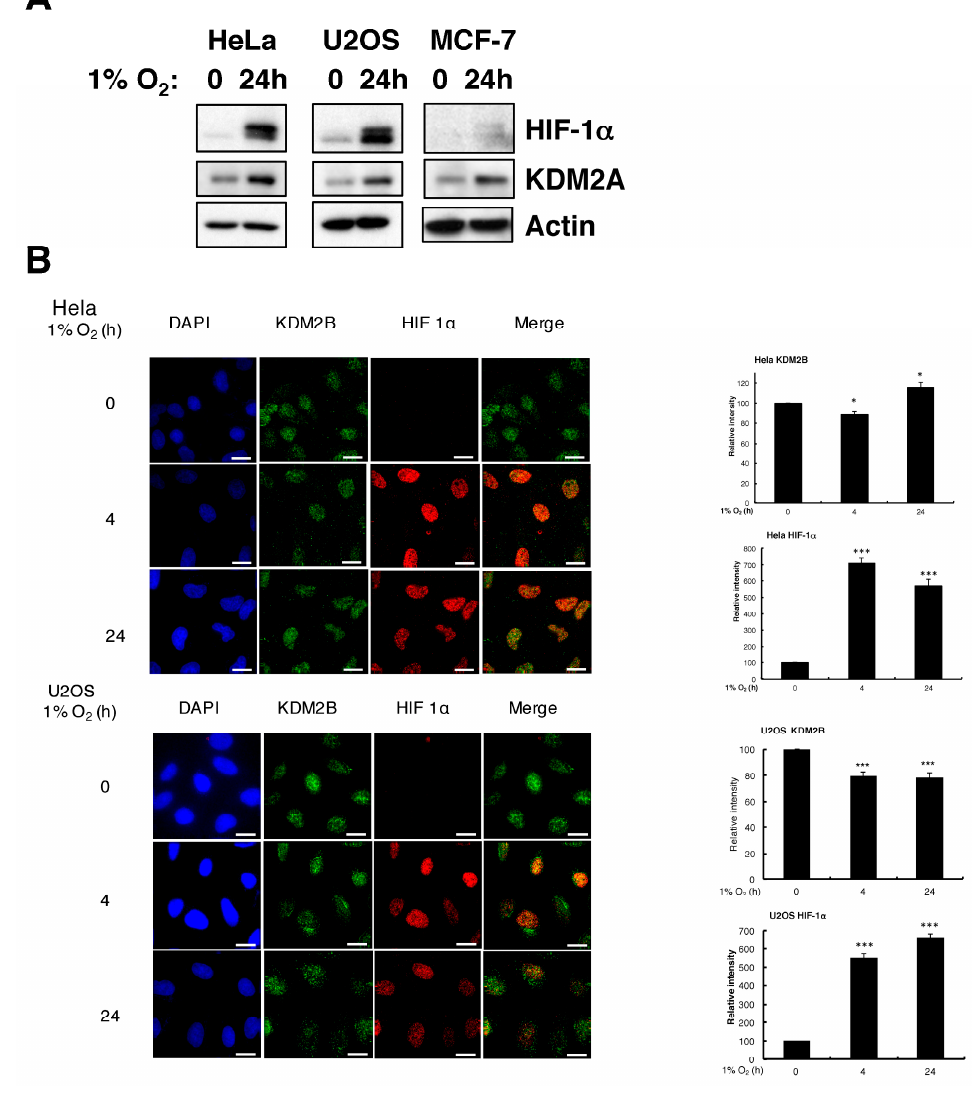
Figure 2. Cont. Figure 2.